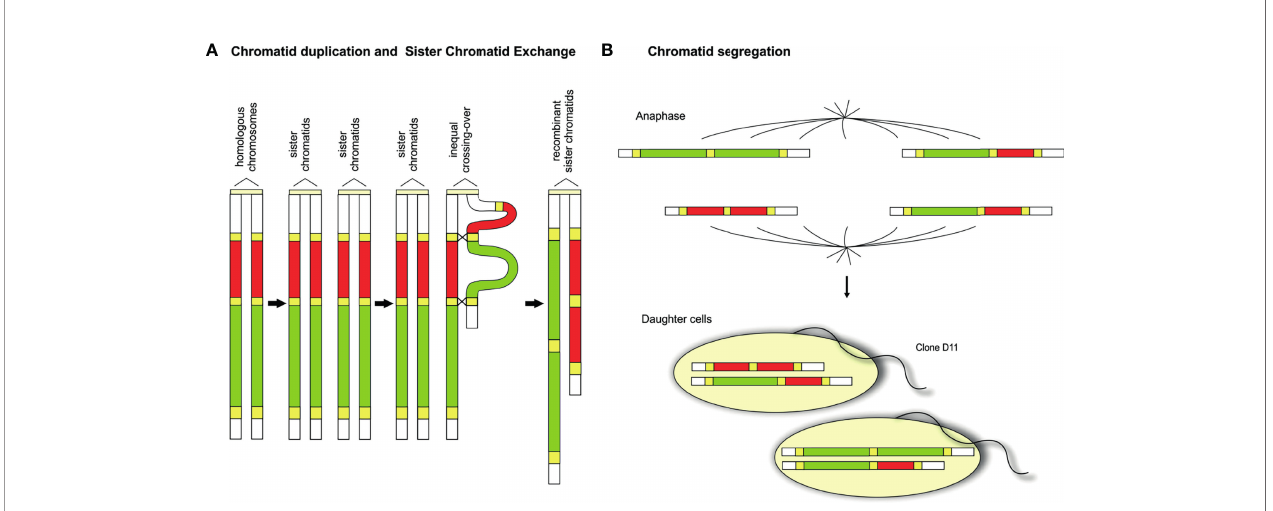
FIGURE 5 | Model of unequal sister chromatid exchange accounting for the rearrangement in the D11 chromosome homologous to TcChr12. (A) The pair of parental homologous chromosomes is shown to the left of the duplicated parental sister chromatids. The repeated sequences (pseudogenes RHS, TS and DGF-1) (in yellow) fl anking the regions involved in the duplication (red) and deletion (green) recombination events are indicated. After DNA replication, the two sister chromatids are paired with slippage of repeated sequences prior to recombination. Unequal sister chromatid cross over resulting in two chromatids of different sizes. (B) At the end of mitotic division two sets of homologous chromosomes are separated from each other in the daughter cells. Each daughter cell receives a sister recombinant chromatid. Clone D11 receives the smaller recombinant chromatid resulting from tandem duplication of a segment (in red) and deletion of the adjacent segment (in